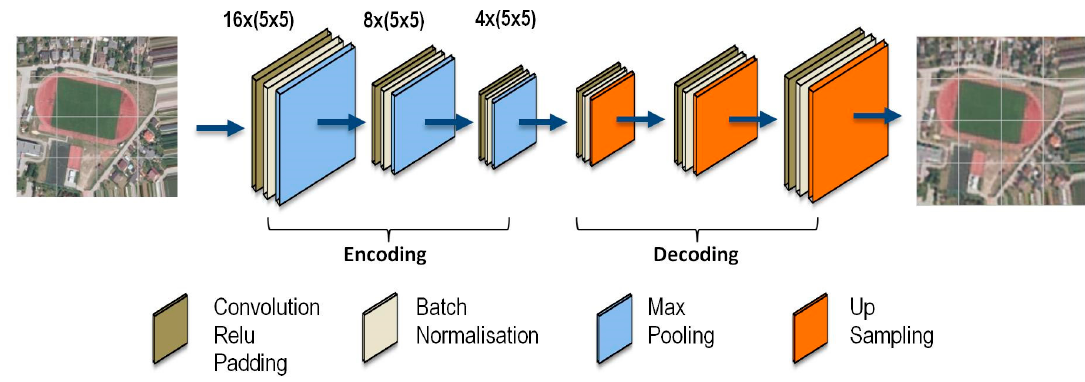
Figure 3. The architecture of the DLA.